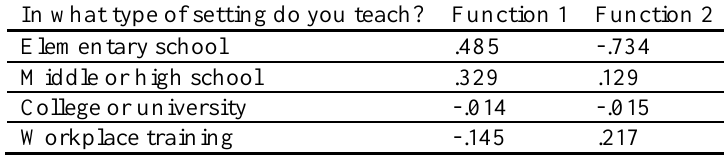
Functions at Group